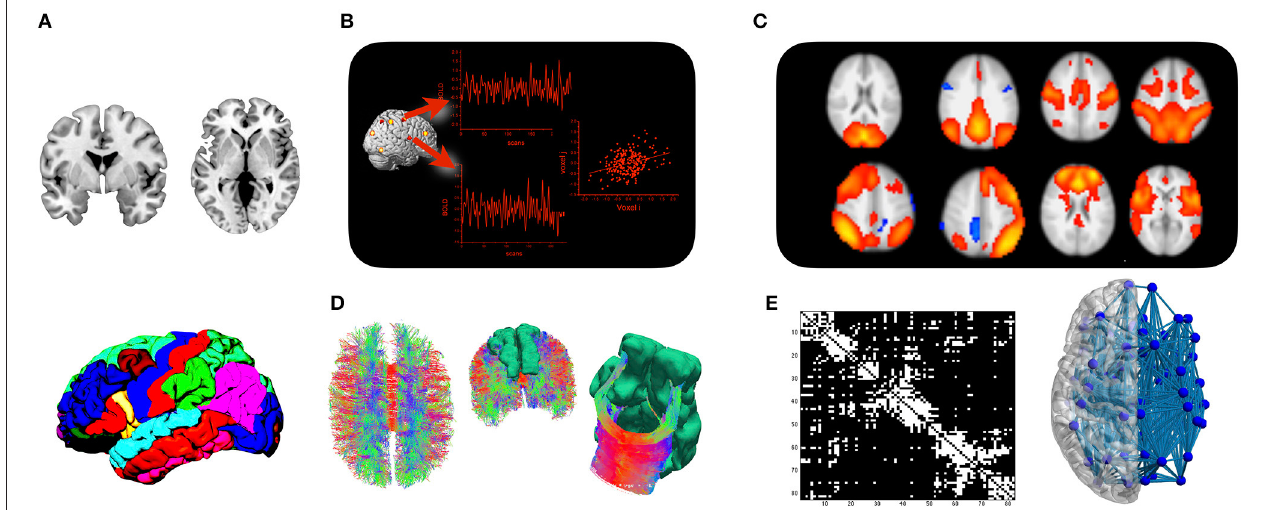
FIGURE 1 | The connectome approach: (A) Cortical and subcortical gray matter are parcellated into a set of regions of interest. (B) Mean time courses of BOLD activity are extracted from each region of interest, and functional connectivity is assessed by analyzing statistical dependencies between any two regions. (C) Functional connectivity is organized into a set of large-scale networks at the brain level. (D) Fiber tracking is applied to diffusion MRI data to assess whether regions from the parcellation are structurally connected. (E) Results are either displayed in a connectivity matrix whose elements indicate whether two regions are connected or not, or displayed in a connectivity plot for anatomical